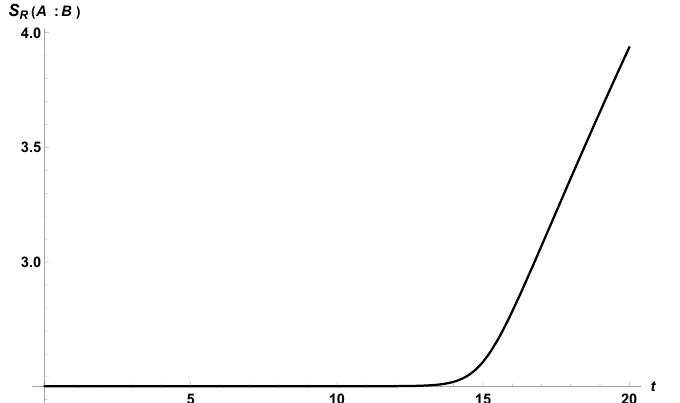
Figure 17. Page curve for the reflected entropy between two fixed adjacent intervals A = [0 , 15] and B = [15 , 25] in a escaping mirror BCFT 2 ; β = 0 . 5 , u 0 = 20 , S bdy = 0 . 4 , c = 1